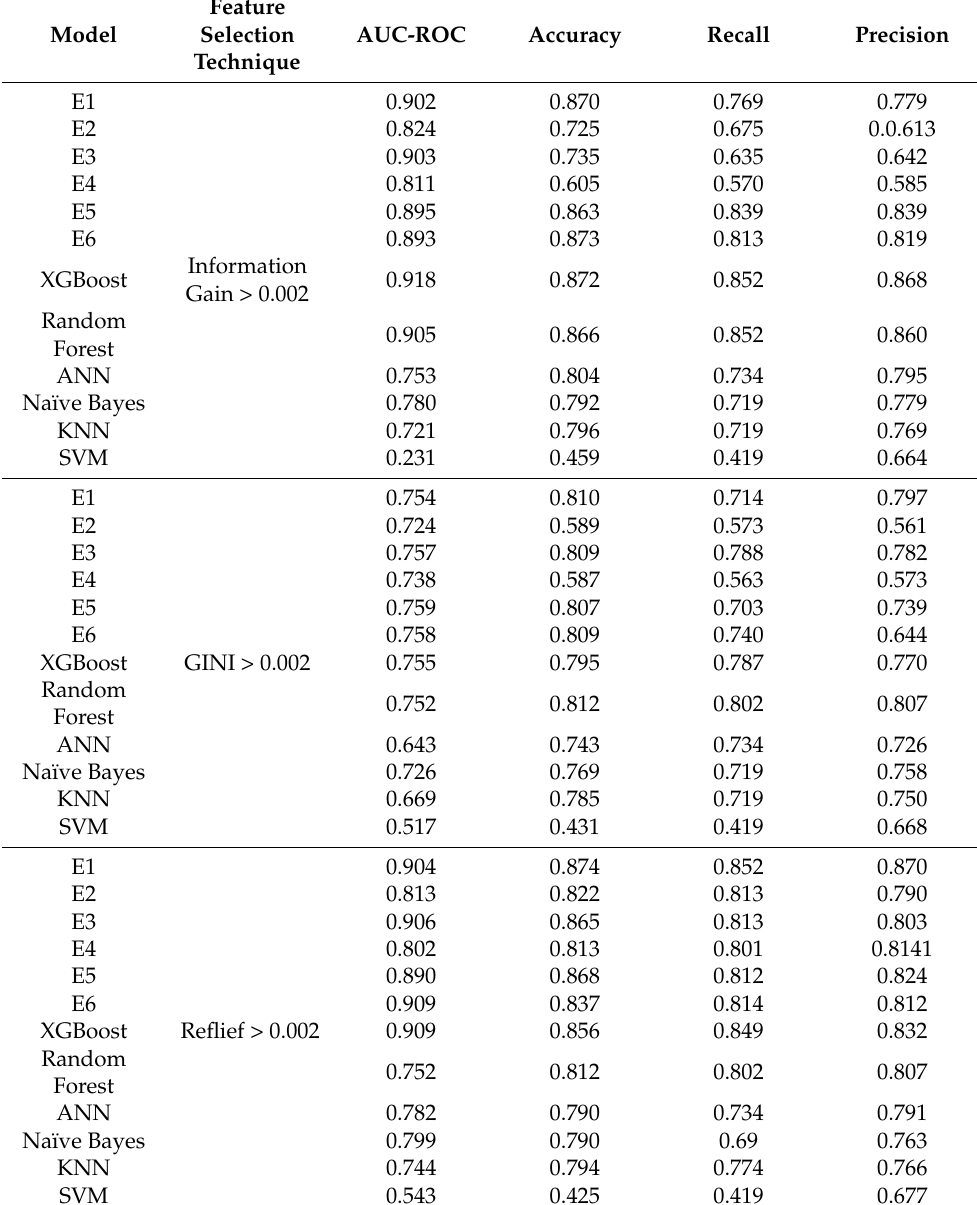
Table 6. Comparison of models results based on feature selection techniques using t = 1 h and look back 24